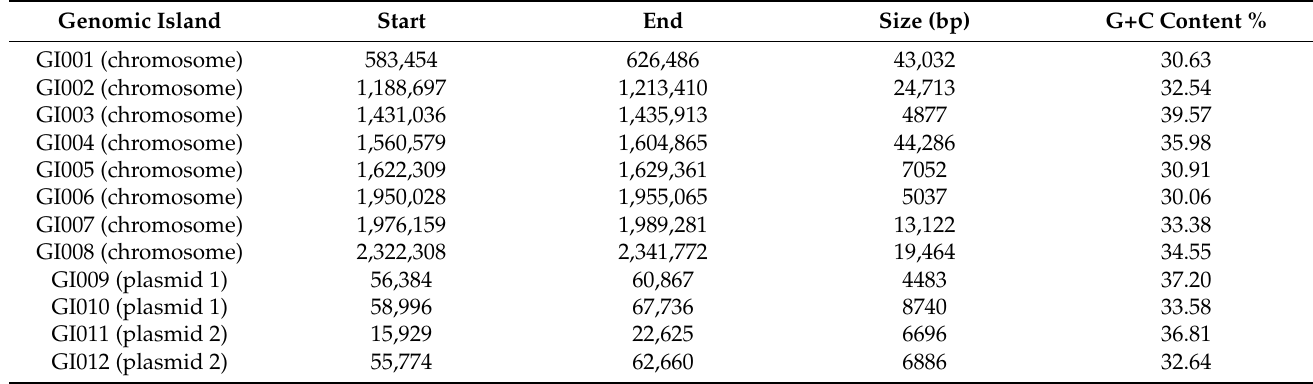
Figure 6. Circular map of L. lactis N8 chromosome and two large plasmids showing the physical location of the 12 GIs. Table 5. Characterization of genomic islands in L. lactis